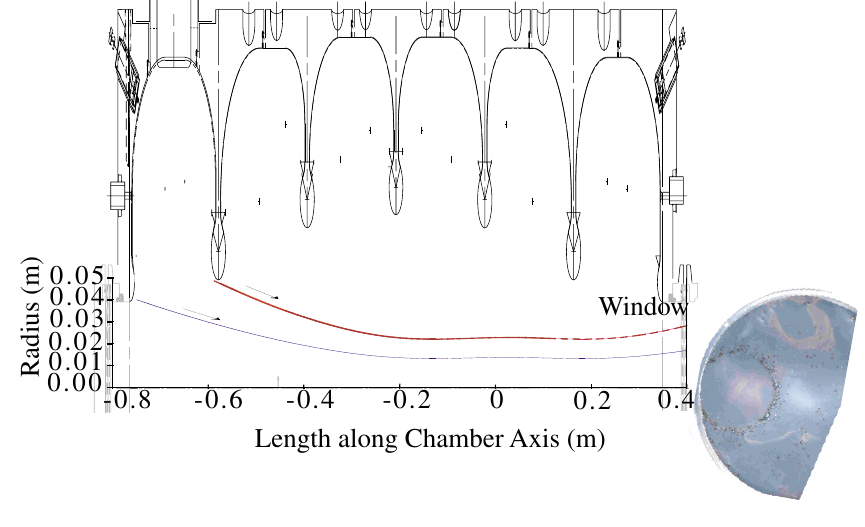
FIG. 16. (Color) The cavity geometry.